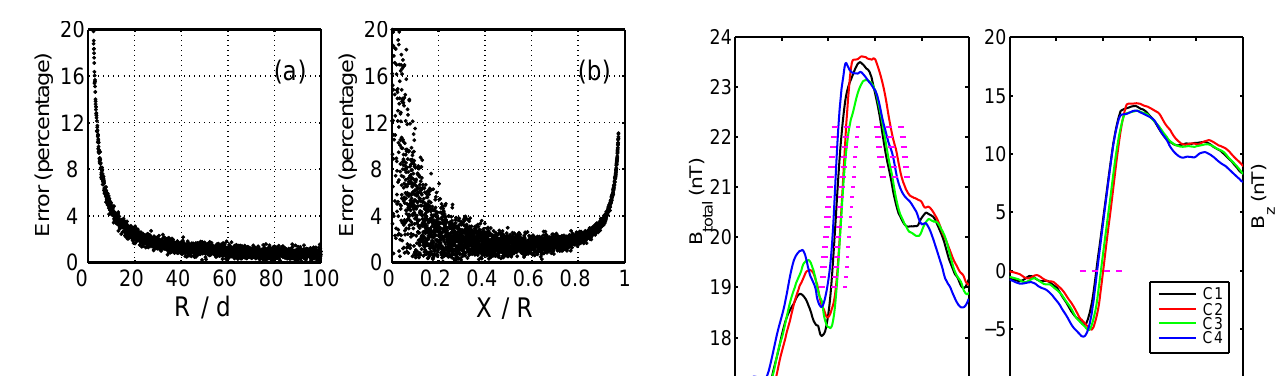
Fig. 2. The error range obtained by the set of MTA tests, selecting 10 contour planes within the structure as the signals. The bootstrap procedure is further applied in each of the MTA tests to display the effect of quantization errors. The difference between the modeled “true” velocity and the MTA velocity, divided by the “true” velocity, can be defined as the error. (a) The error versus flux rope radius R (normalized to d =400km) in a certain type of Cluster trajectory with X (the constellation’s closest distance to the axis) of 0.707 R . (b) The error dependency on X , which is normalized to the structure radius R ), when R is fixed to be 30 times greater than the satellite separation d .